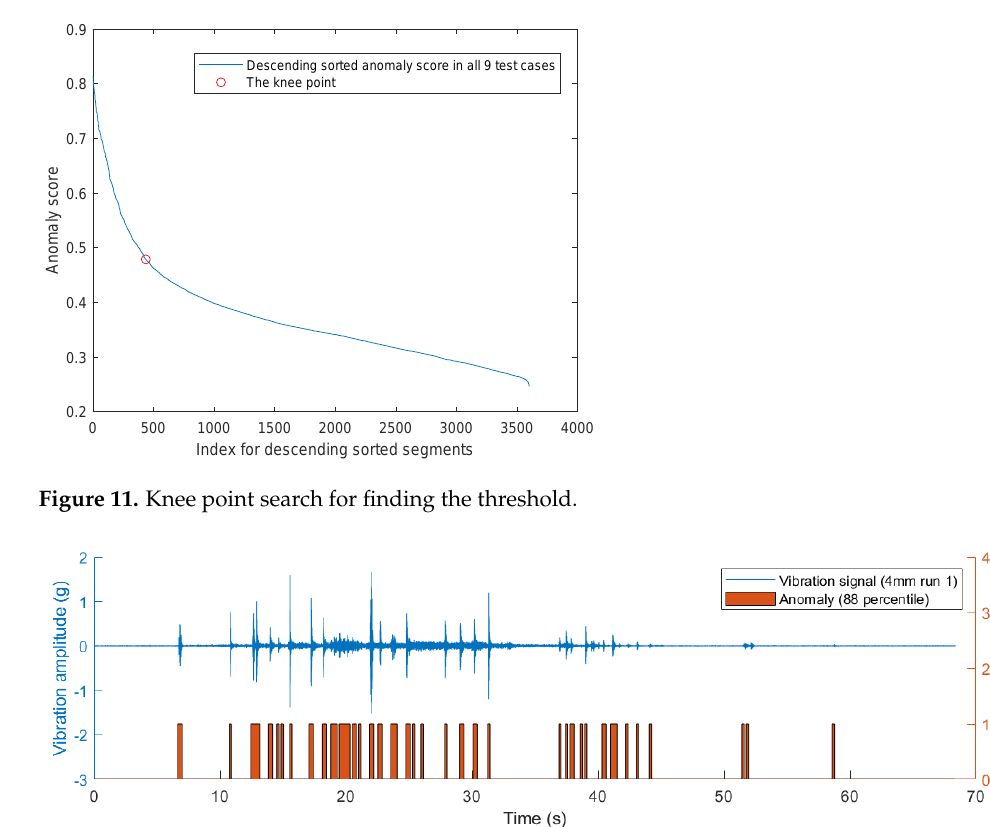
Figure 12. Example anomaly detection for run 1 of the 4 mm squat case with the 88th percentile as the threshold.